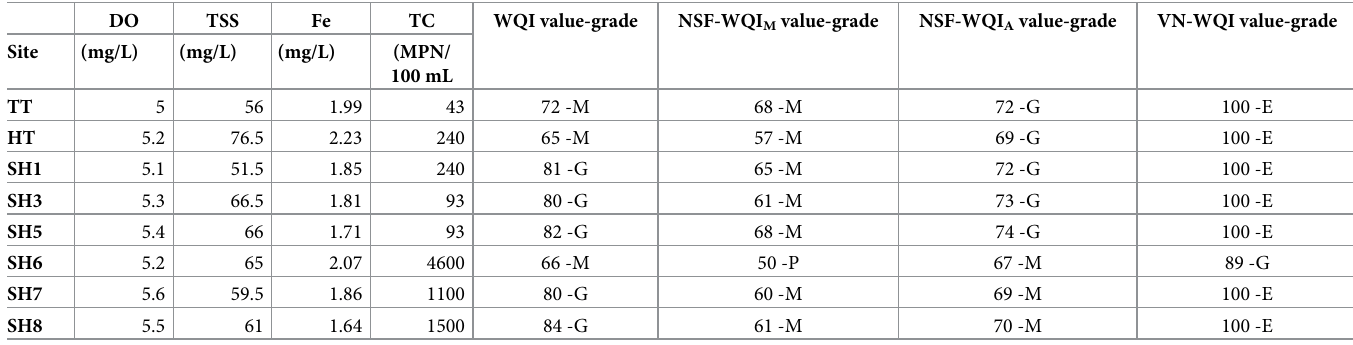
Table 6. The DO, TSS, Fe and TC concentrations, WQI, NSF-WQI and VN-WQI values, and the respective grades for the monitoring session in Nov. 2020 ( � )